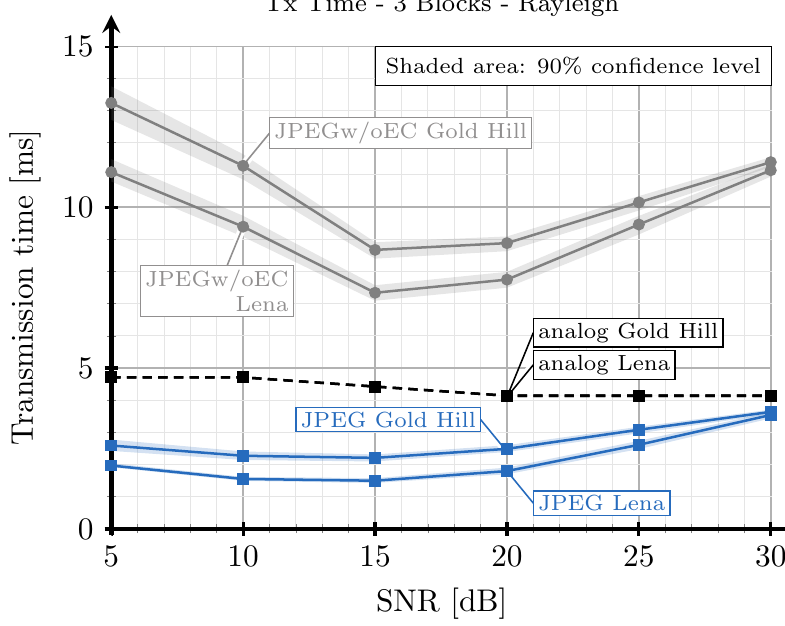
Figure 11. Transmission time vs. SNR for three blocks and Rayleigh channel.